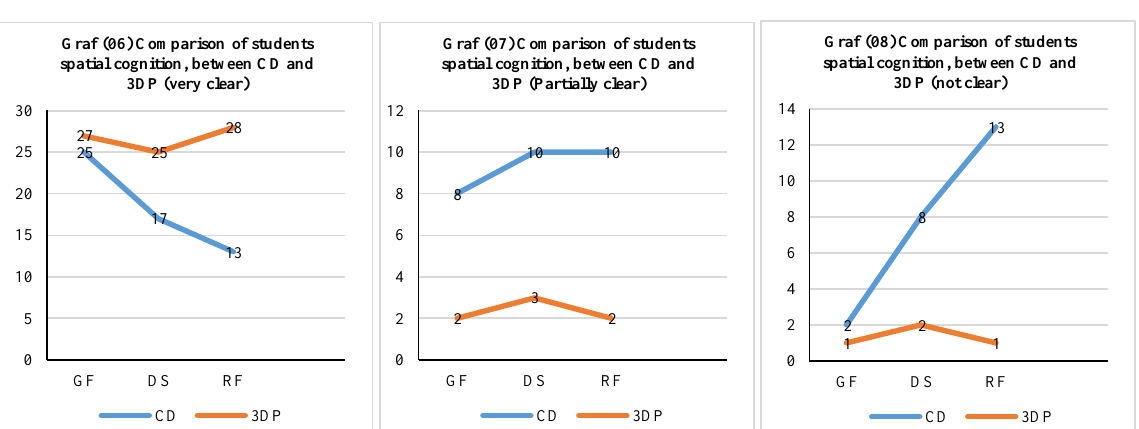
Figure 6. 3DP positive effects on students’ spatial perception.